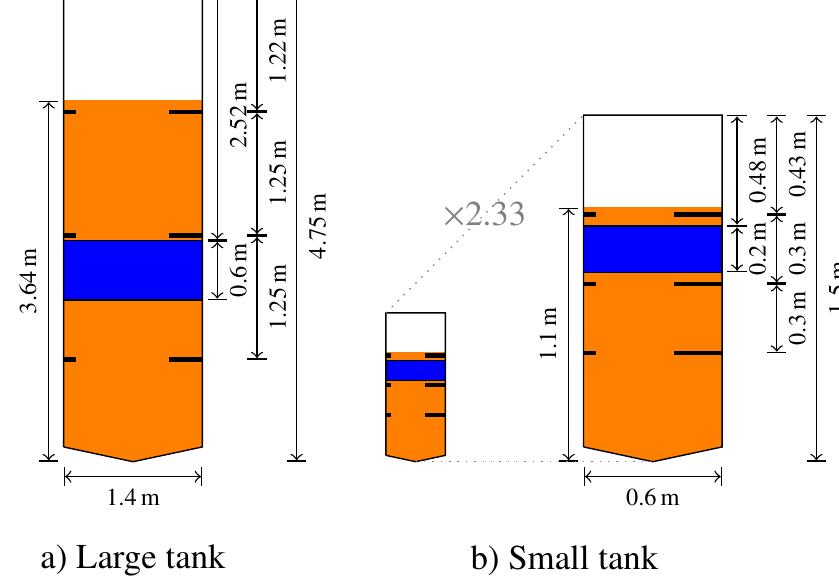
Figure 4. Dimensions, cooling jacket configuration and sensor locations of the ( a ) large and ( b ) small case study tank. To compare sizes the large tank and left version of the small tank are drawn on the same